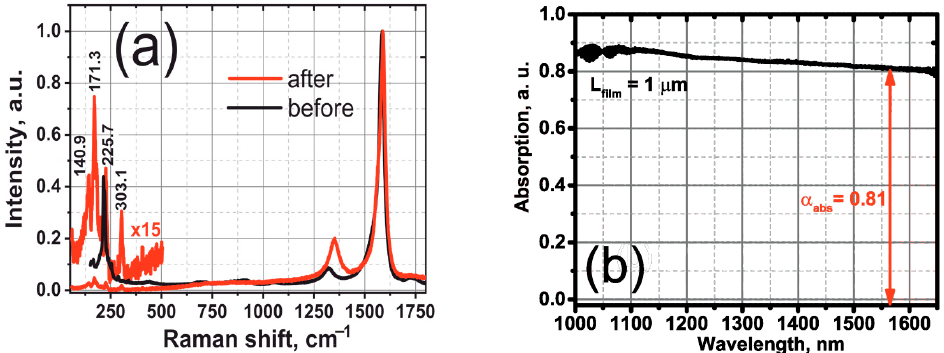
Figure 1. SEM images of ( a ) the initial SWCNTs, and ( b ) after high-pressure high-temperature treat- ment.